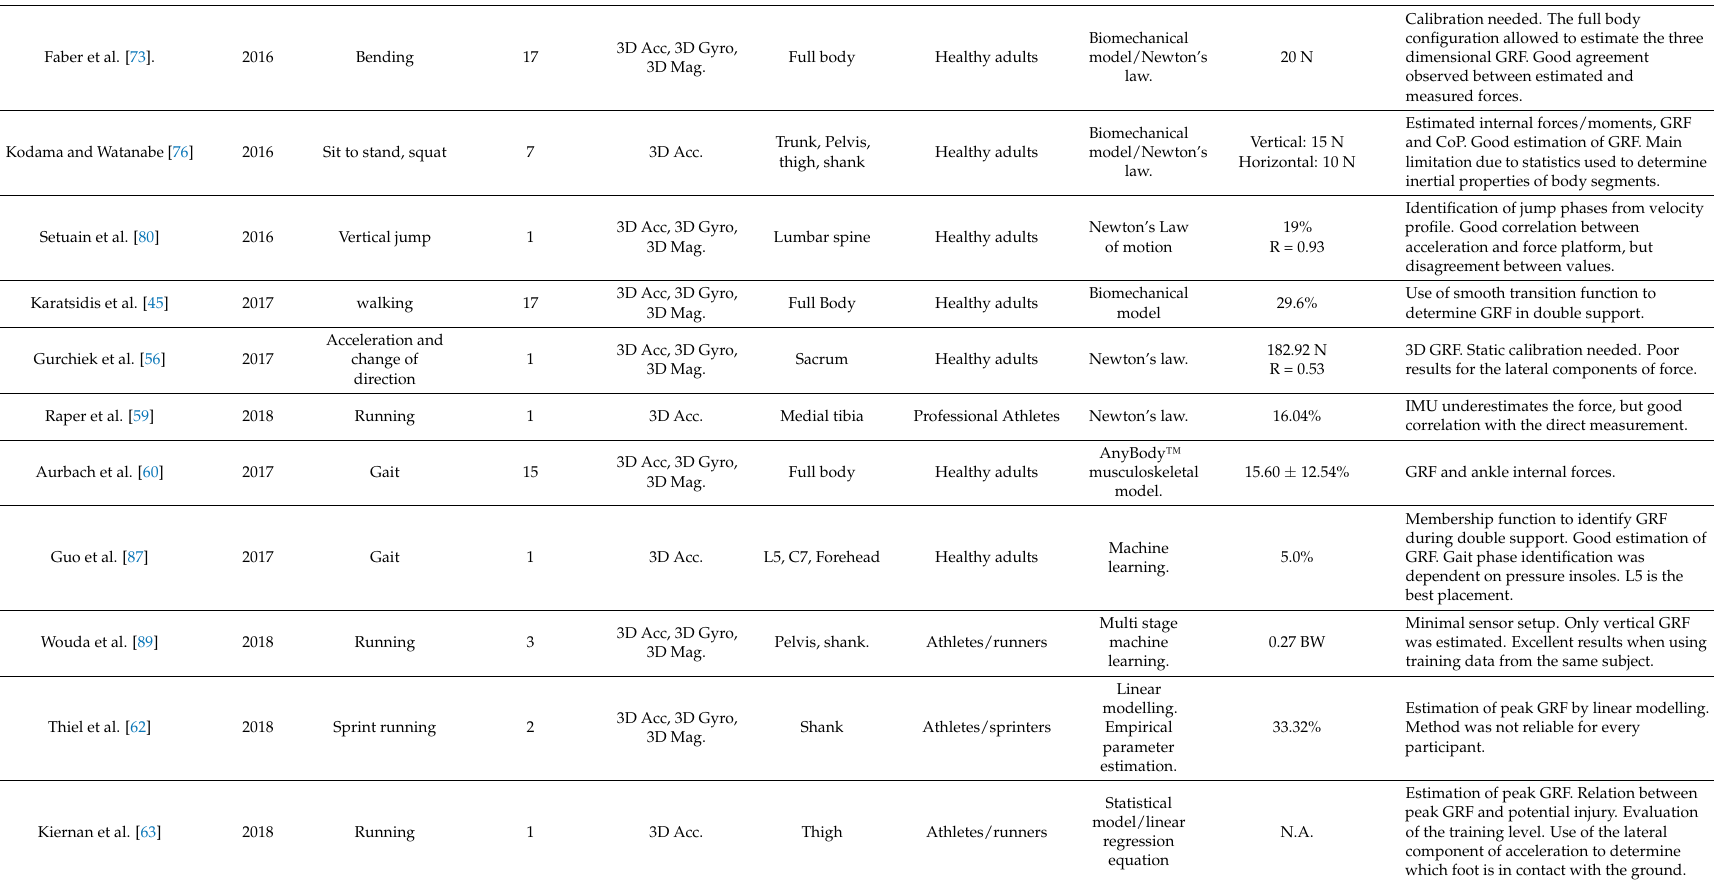
N.A. which foot is in contact with the